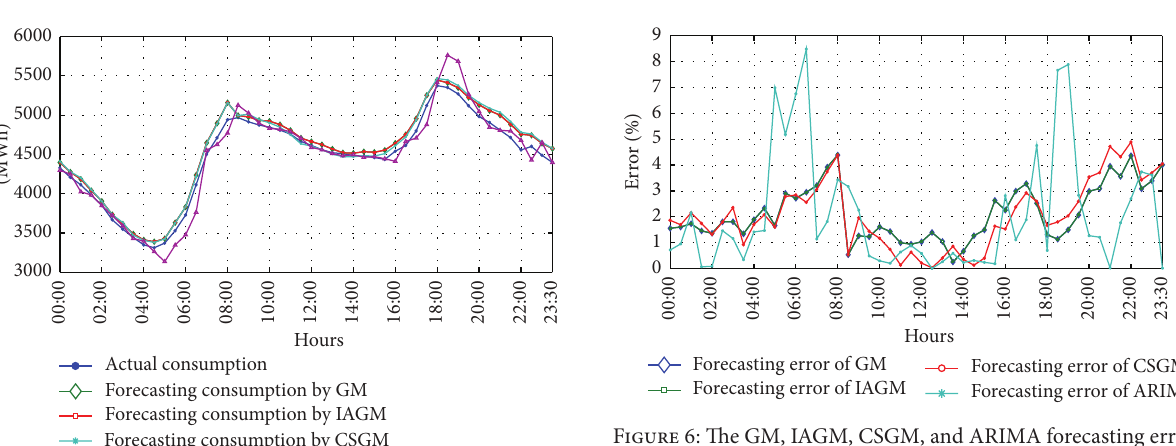
Figure 6: The GM, IAGM, CSGM, and ARIMA forecasting